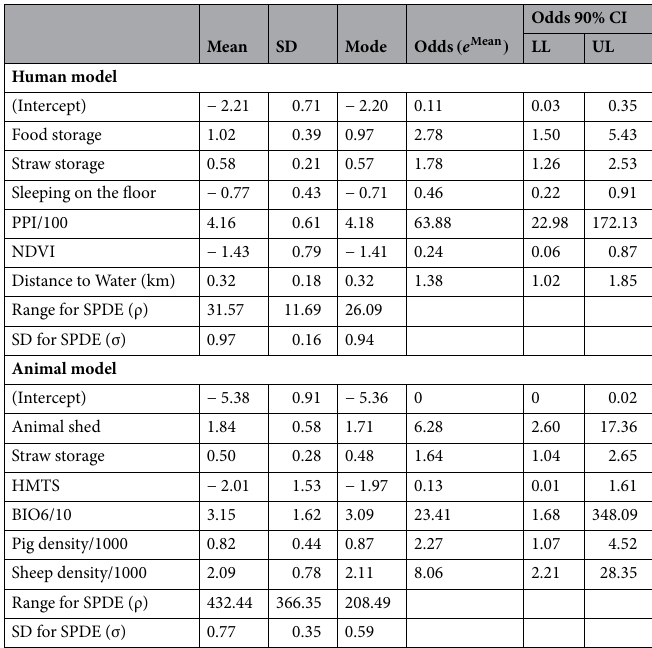
Table 1. Estimated parameters of the fitted hierarchical Bayesian models for the human and the animal risk of snakebite in the Terai. Reported statistics are the posterior marginal mean, standard deviation and mode (logit scale), as well as the corresponding mean, 90% lower- and upper-limit credible interval (odds scale). The bottom rows in each model report the spatial random effects hyperparameters. Other abbreviations: Human modification of terrestrial systems (HMTS), minimum temperature of the coldest month (BIO6), Stochastic Partial Differential Equations